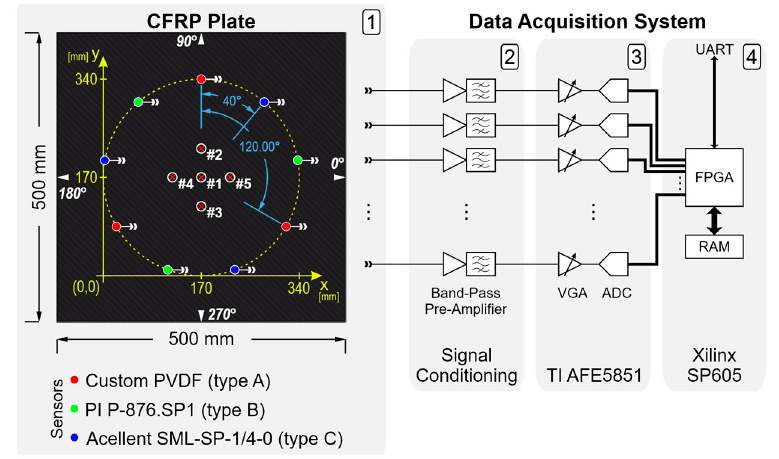
Figure 1. Block diagram of the data acquisition system and drawing of the test object: ( 1 ) Sensor layout on the Carbon Fiber Reinforced Polymer (CFRP) plate, coordinate reference system, and impact markers (#1, #2, #3, #4, #5), labels 0°, 90°, 180°, 270° indicate the angular directions used for measuring the Lamb wave group velocities; ( 2 ) signal conditioning electronics; ( 3 ) multichannel VGA with ADC evaluation module (Texas Instruments AFE5851EVM, Dallas, TX, USA); ( 4 ) Spartan-6 FPGA evaluation card (Xilinx SP605).